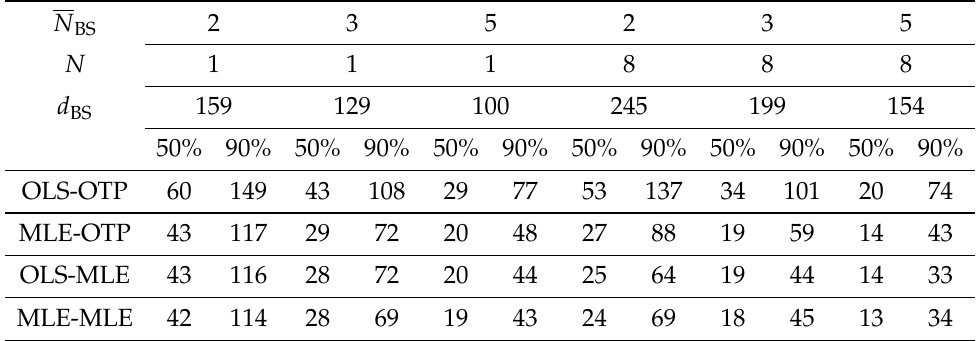
Table 3. Positioning error, in meters, 50th and 90th percentiles of Example 1. Base stations have omnidirectional ( N = 1) or directional antennas ( N = 8) and the average number of contacted BSs is N BS = 2, 3, or